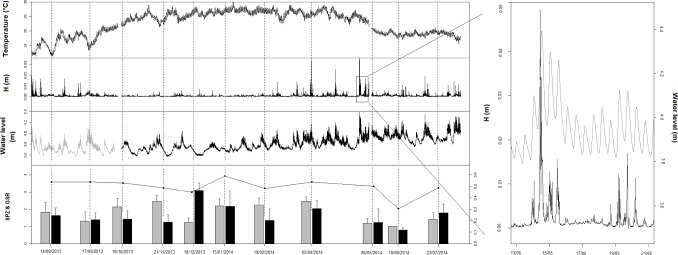
Physical characteristics of the Tatakoto lagoon from August 2013 to July 2014.Dashed vertical lines indicate when gonads were sampled. The lower panel displays values for the maturity indices SPZ (grey) and GSI (black), as well as the relative proportion of male and female tissues (GSR, black joined dots) obtained at each gonad sampling event. The water level line is greyed out before 15/10/2013 as the sensor was placed slightly deeper than usual on its pedestal (20 to 40 cm). Right panel is a zoom of water level (grey) and mean wave height (black) for the period 13–21 May.